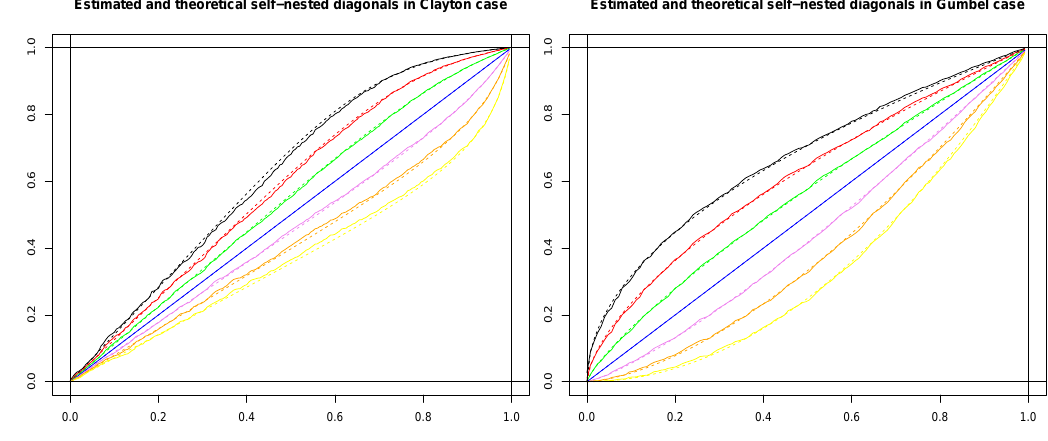
u Figure 2. Estimation of self-nested diagonal b δ k ( u ) as in Definition 4.2 in the Clayton-case with parameter θ = 6 (left), or in the Gumbel-case with parameter θ = 3 (right) for k = − 3 ,− 2 ,− 1 , 0 , 1 , 2 , 3 . The estimated b δ k ( u ) are represented using full lines, the theoretical one’s using dotted lines. The black upper curve corresponds to k = − 3 , the yellow lower curve to k = 3